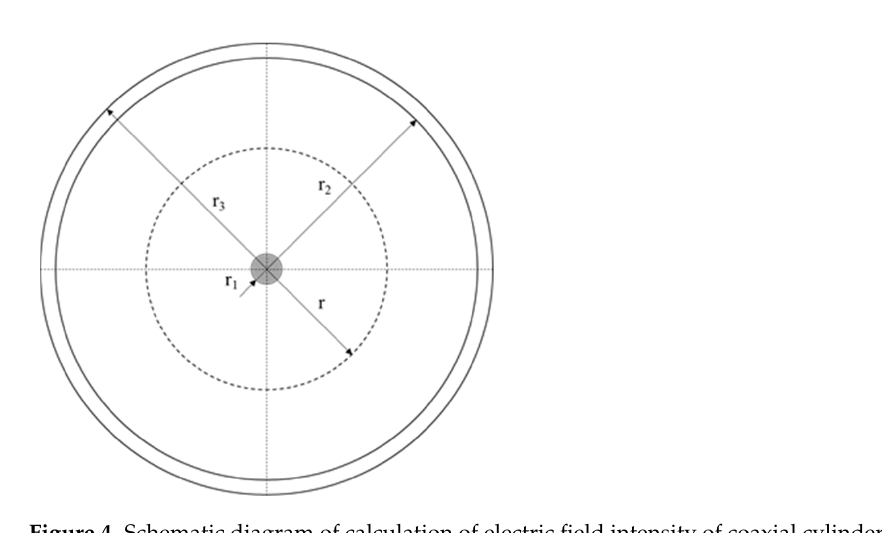
Figure 4. Schematic diagram of calculation of electric field intensity of coaxial cylinder. The swirl burner nozzle is located 400 mm below the top of the combustion chamber. The swirl burner is formed by adding a swirler to the jet burner nozzle. The bottom of the swirler is composed of 8 rotating guide vanes with a swirl angle of 45 ◦ , the center diameter is 8 mm, and the swirl intensity S is 0.8, as shown in Figure 5.